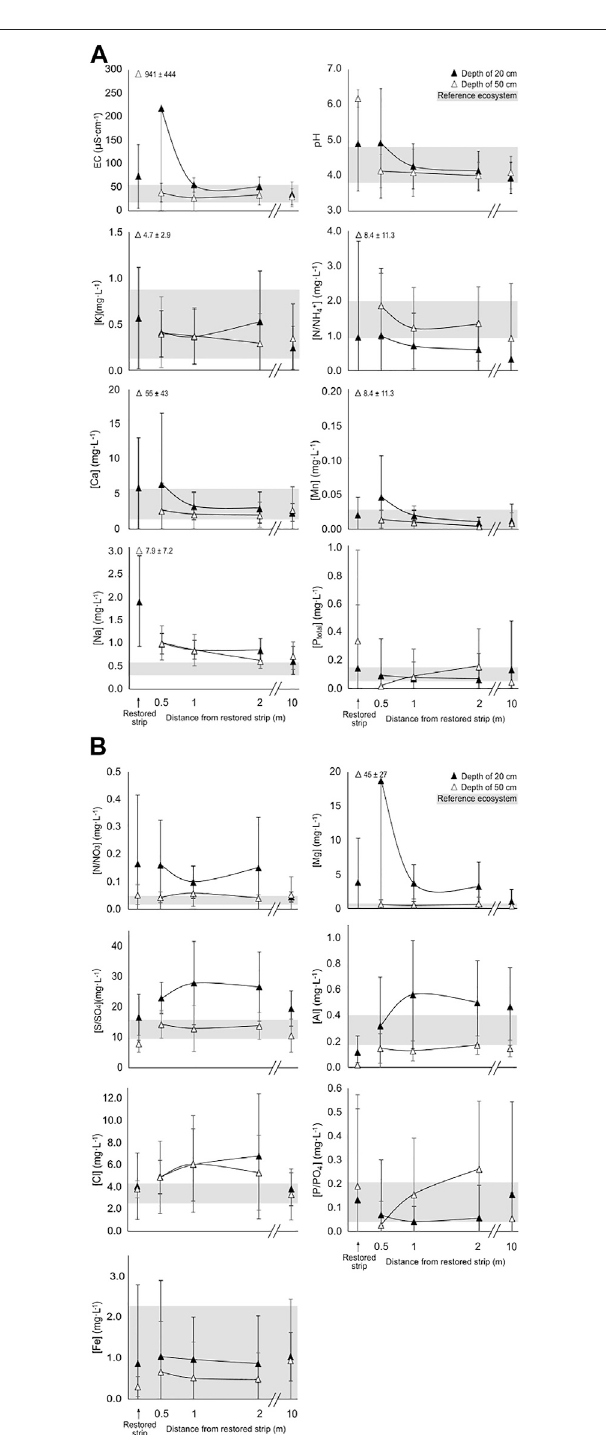
FIGURE 3 | Mean pore water ( ± CI 95% ) of corrected electrical conductivity (EC), pH and concentration of K, N/NH4+, Ca, Mn, Na, Ptotal, N/NO 3 , Mg, S/SO 4 , Al, Cl, P/PO 4 and Fe ( n (cid:2) 4, data combined from two sampling campaigns in June and September 2015) sampled at two depths(20and 50 cm)intherestored stripand at0.5,1,2,and10mfromthe restored strip. The gray area represents the mean of the reference ecosystem (nearby pristine peatland) values (mean ± CI 95% , n (cid:2)